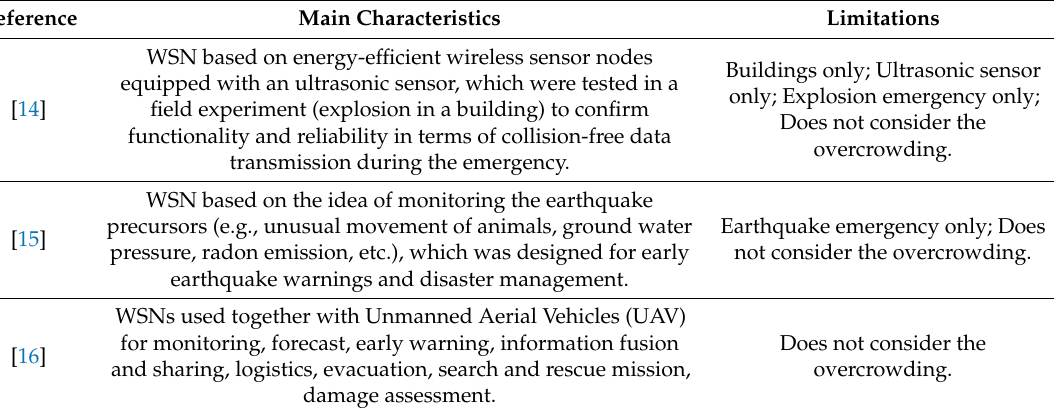
Table 1. Examples of Wireless Sensor Networks (WSN) and Internet of Things (IoT)-WSN solutions for emergency and disaster